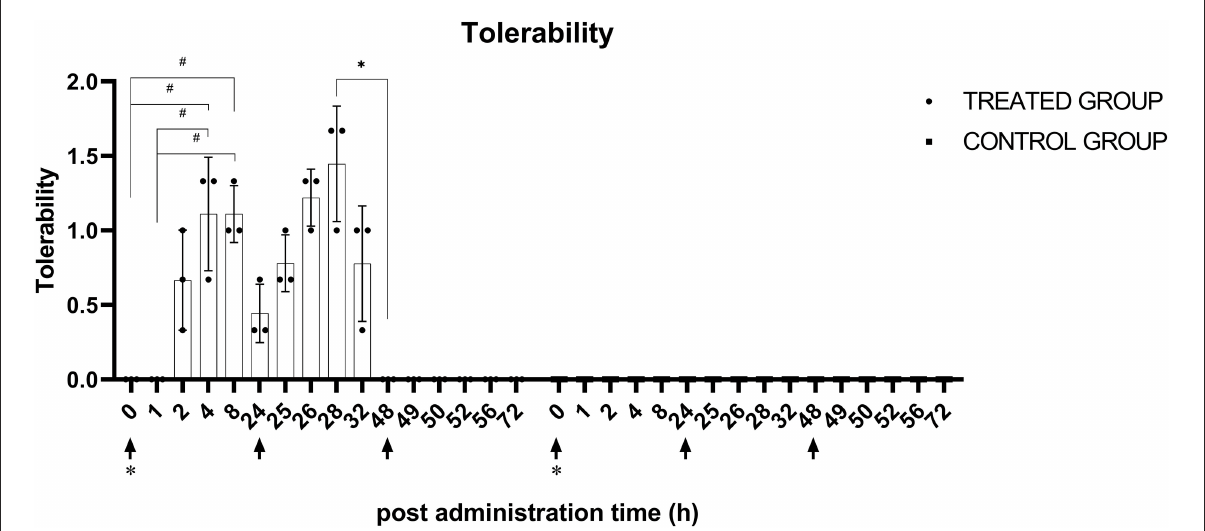
FIGURE4 Tolerability score after KMRC011 or normal saline administration. KMRC011 was administered (solid arrows) at 0, 24, and 48h after irradiation (asterisk). Tolerability score in the treated group showed significant elevation within 1–2h after the first and second administration and decreased within 4–8h after the administration. After the third administration, there were no changes in tolerability score. The Control group showed no observable changes after the administration. * p < 0.05; # p < 0.05, largest difference without statistical significance in the post-hoc analysis.